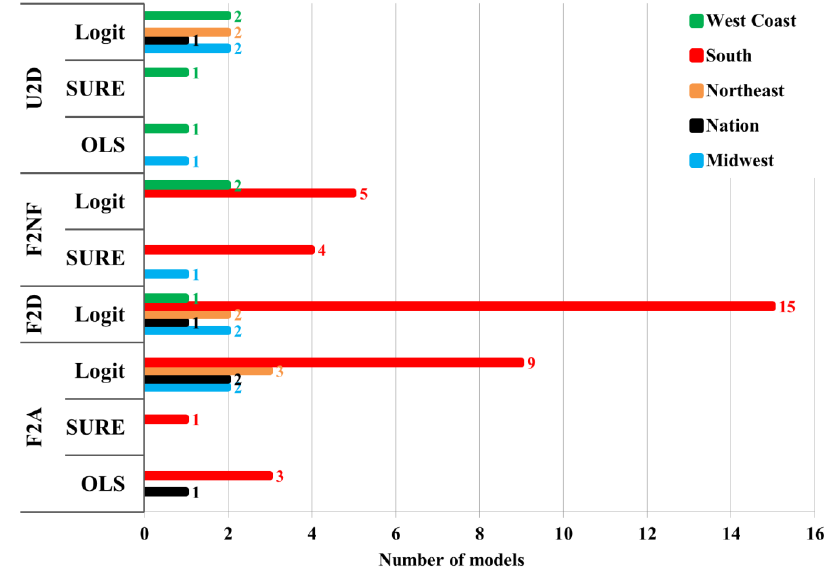
Figure 3. Model specifications by geographic region and model types included in a meta-analysis of 64 econometric models predicting forestland